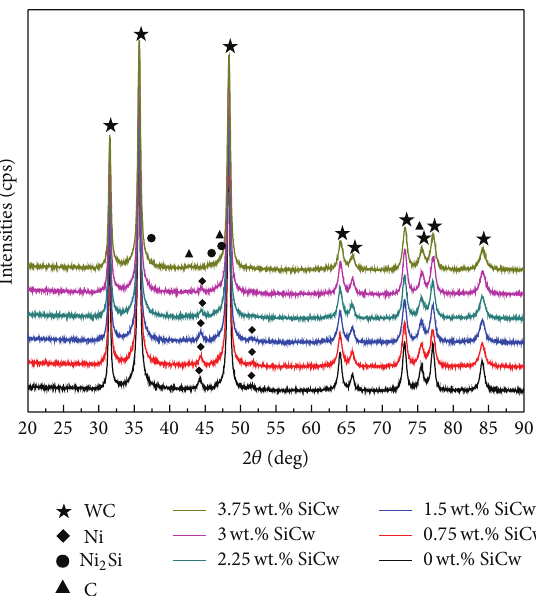
Figure 2: XRD patterns of the as-prepared WC-Ni cemented car- bides with varied fractions of SiC